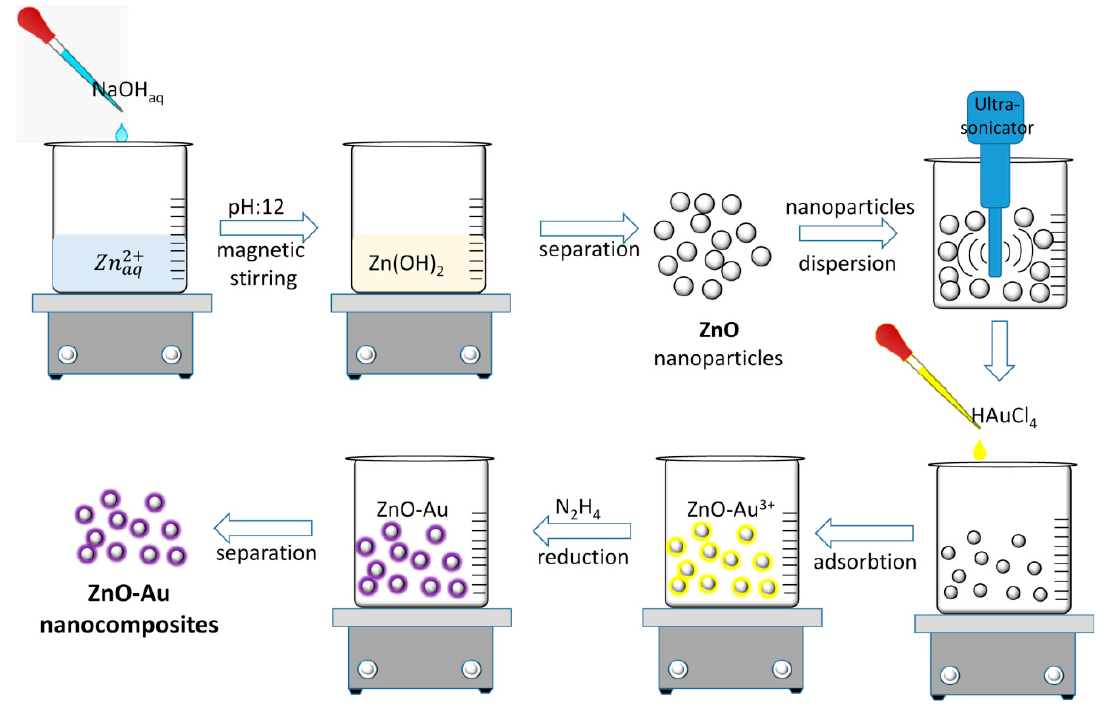
Figure 1. Schematic representation of the synthesis steps for obtaining ZnO-Au nanocomposites.